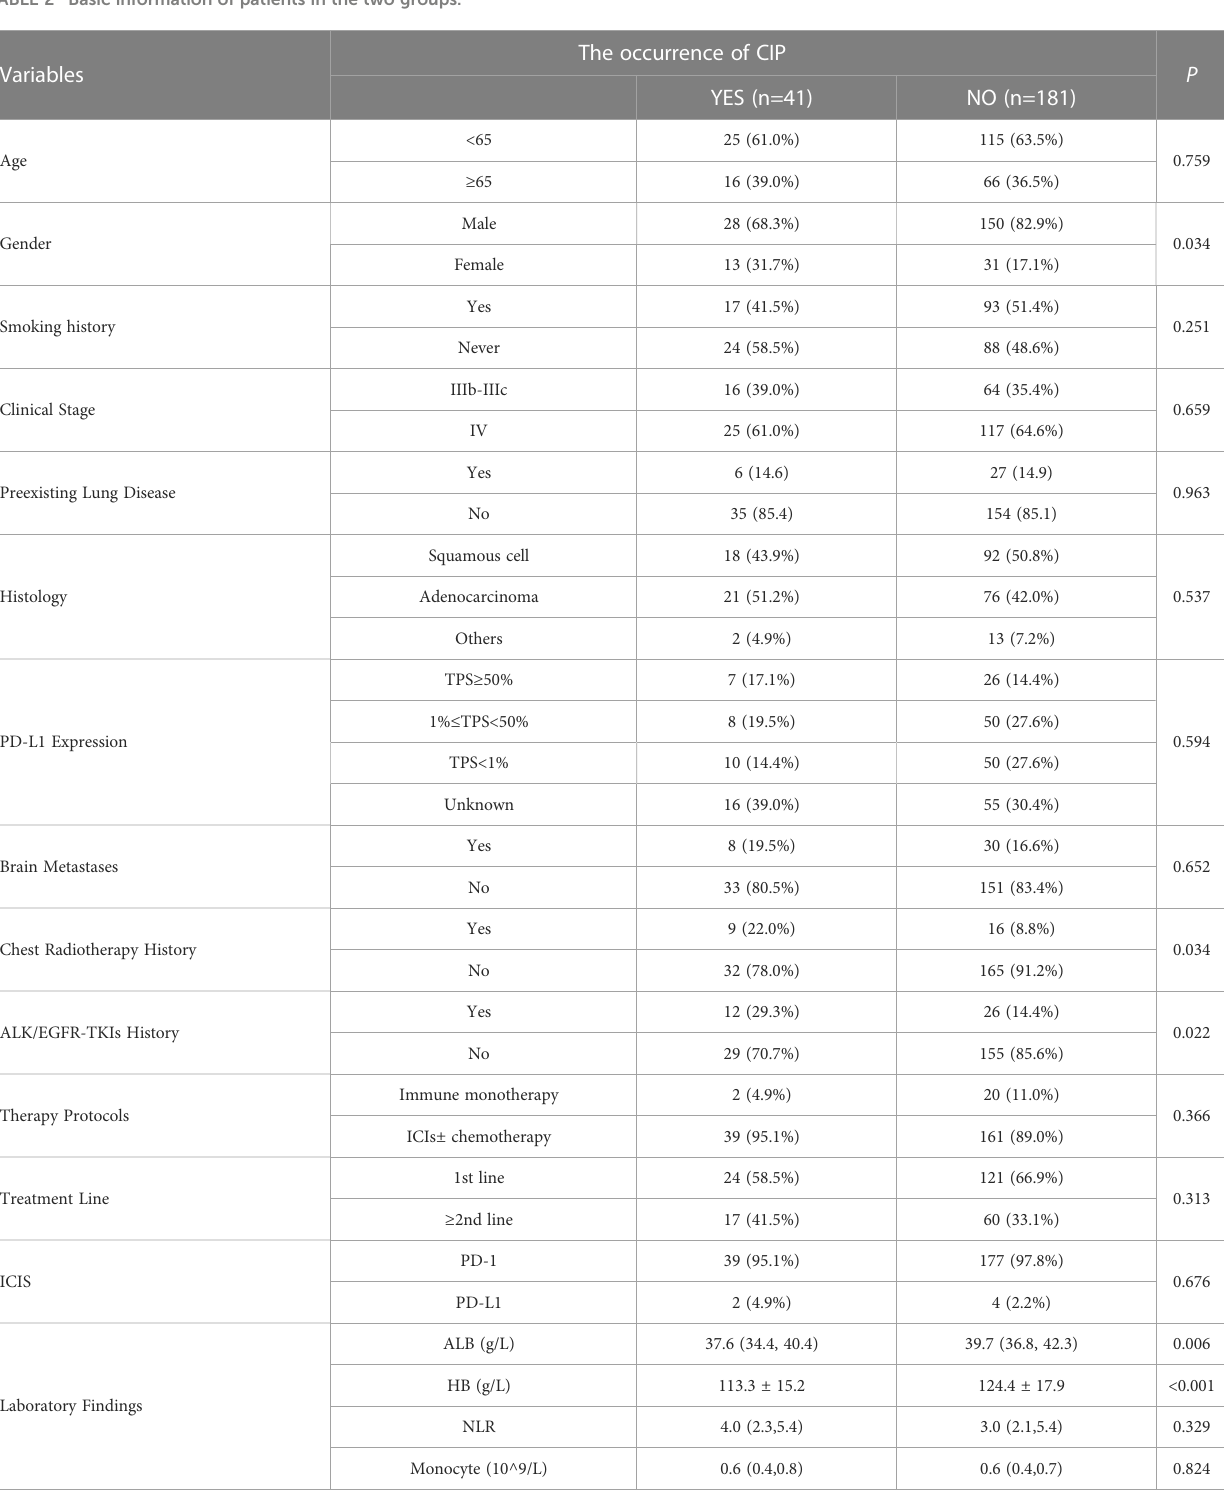
TABLE 2 Basic information of patients in the two